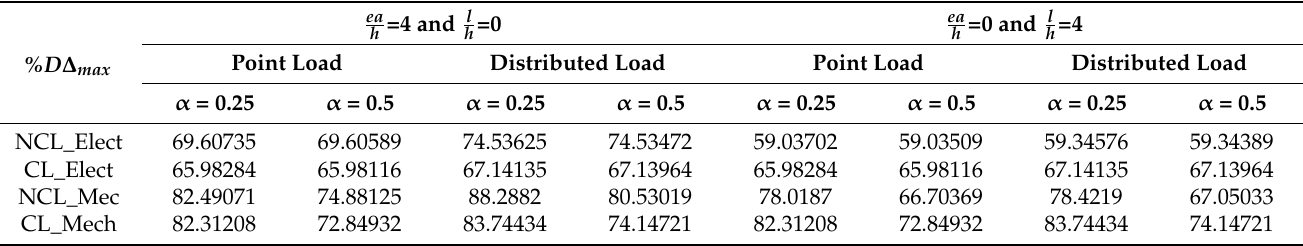
73.8111 The dependency of the nondimensional bending deflection on the perforation filling ratio for electromechanical and mechanical nonclassical and classical behaviors under uni- formly distributed and point loads is shown in Figure 6. It may be noticed that, due to